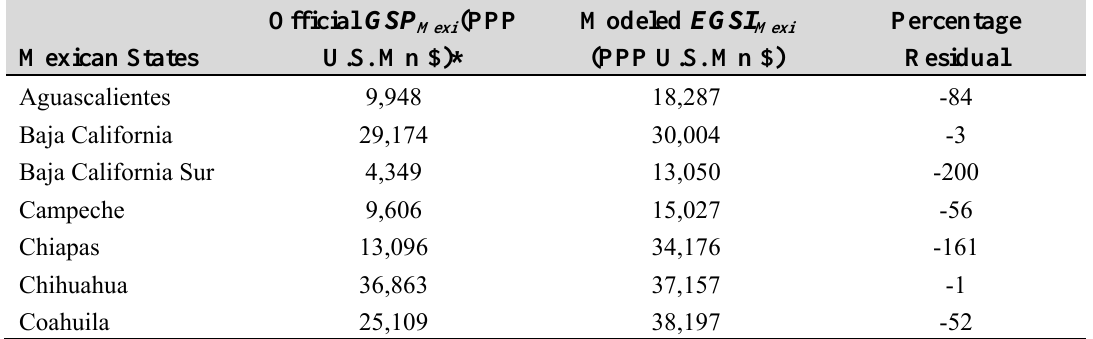
, Modeled EGSI and Percentage Residual for each Mexican Mexi Mexi